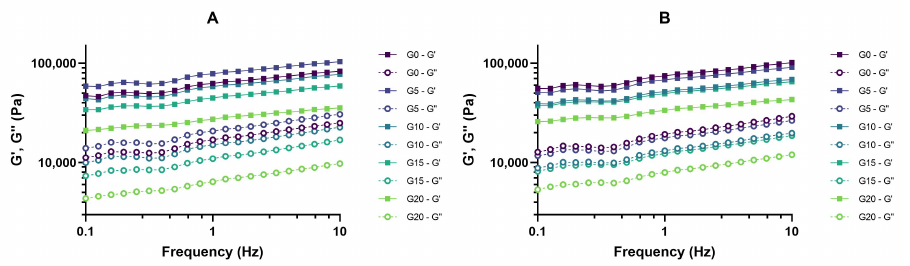
Figure 6. Frequency sweep of fermented PPI gels after ( A ) 1 day and ( B ) 7 days of storage under refrigeration in closed containers. Continuous lines correspond to the elastic modulus (G (cid:48) ) and discontinuous lines to the viscous modulus (G (cid:48)(cid:48)